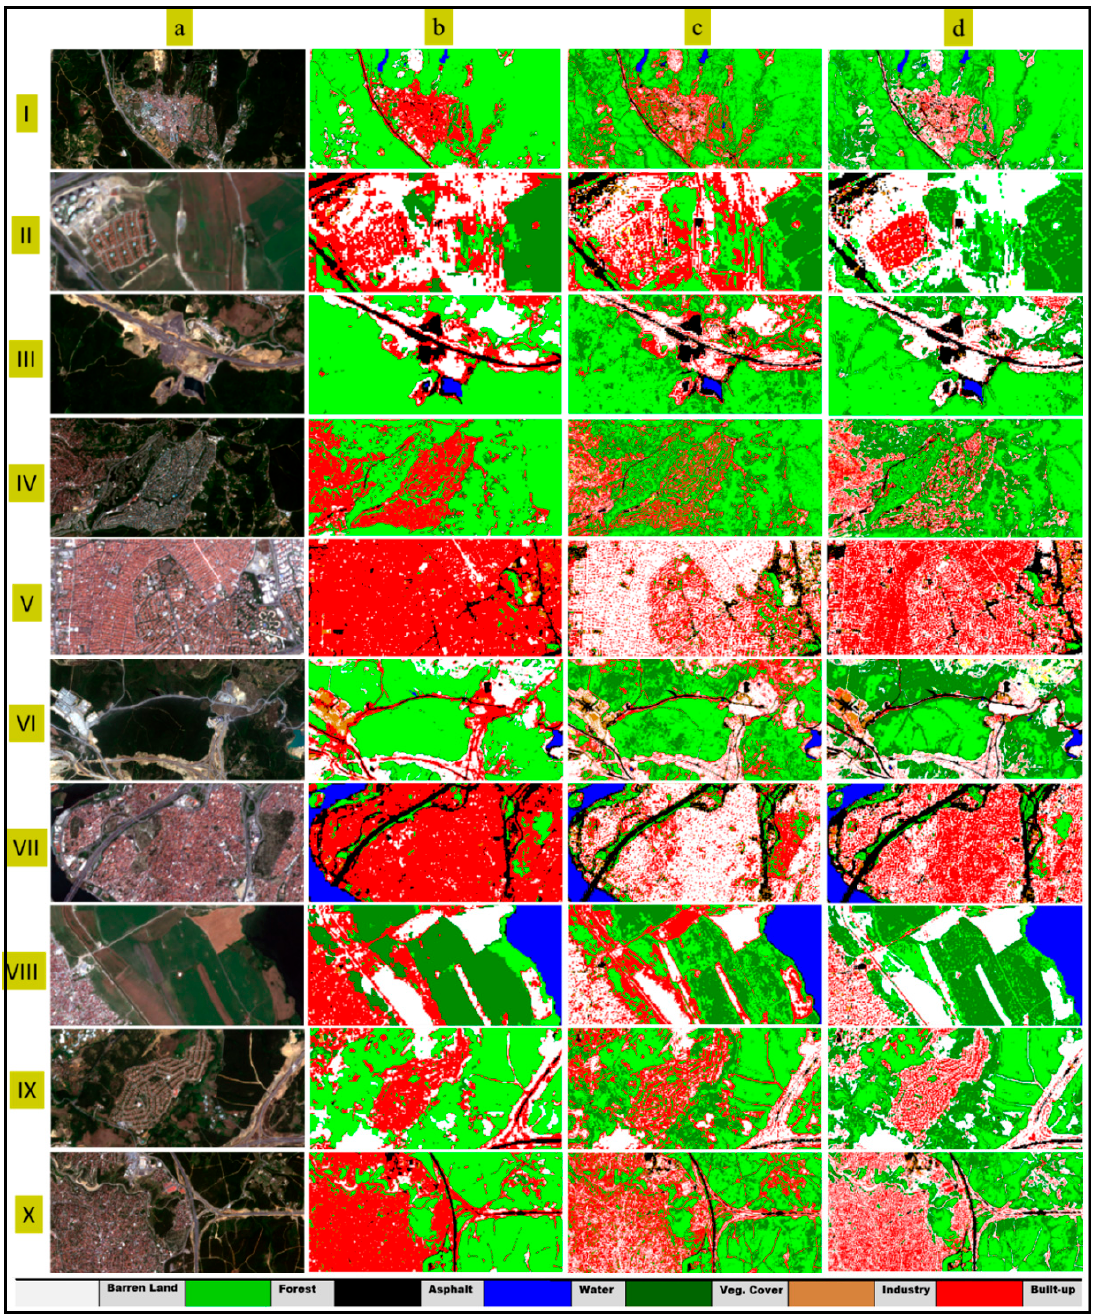
Figure 10. ( a ) RGB image of the Sentinel-2A; ( b ) classified Sentinel-2A; ( c ) classified multi-index (NDBI, NDVIre, MNDWI); and ( d ) classified multi-index (NDTI, NDVIre, MNDWI) images.